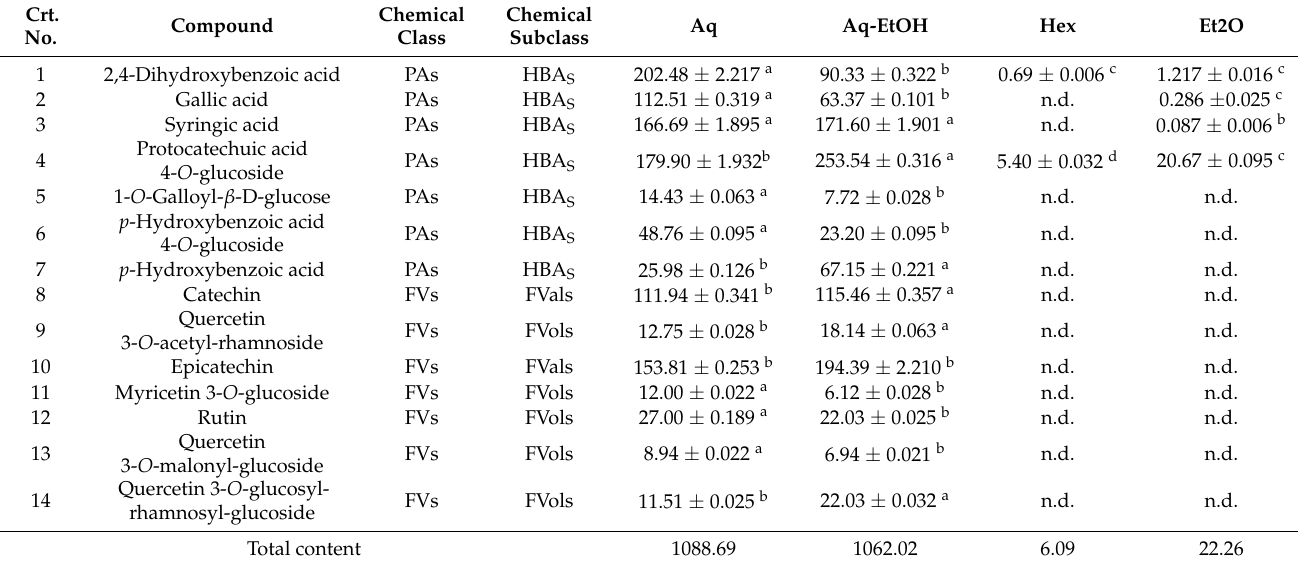
Table 4 contains values of polyphenolic compounds detected in C. cibarius mushroom extracts. As with B. edulis ones, flavonoid compounds were not recovered by hexane and ether. Fourteen compounds were found in C. cibarius mushrooms. The predominant chemical constituents were phenolic acids [69.0% in Aq (69.0% HBAs); 63.7% in Aq-EtOH (63.7% HBAs), 100% in Et2O (100% HBAs), and 100% in Hex (100% HBAs)], followed by flavonoids [31.0% in Aq (6.6% FVals and 24.4% FVols) and 36.3% in Aq-EtOH (7.1% FVals and 29.2% FVols)]. Table 4. Content of polyphenolic compounds ( µ g/g dw) in C. cibarius extracts. Crt.